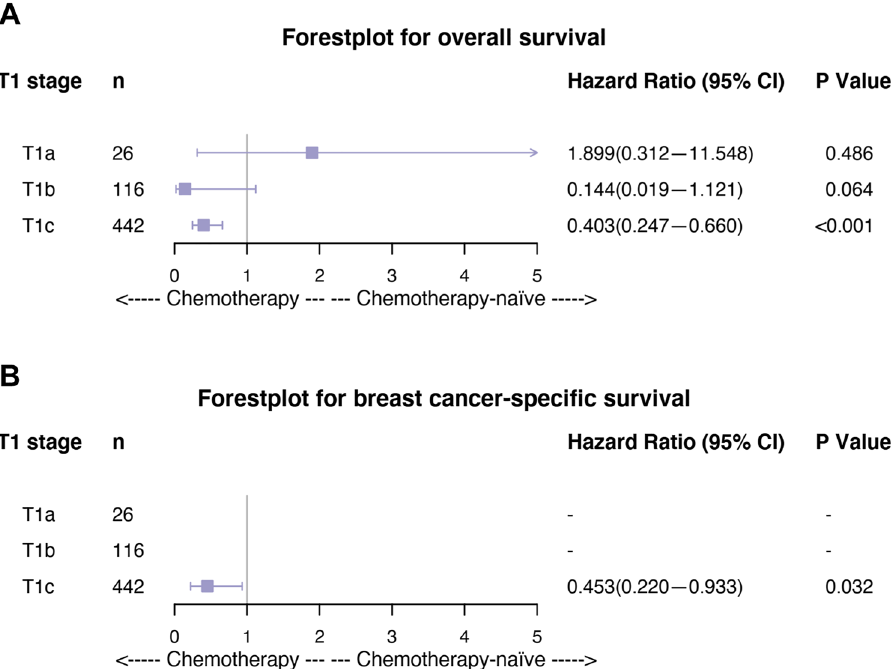
Figure 4. Forest plot of different T1 stage subgroups of MpBC patients. ( A ) Overall survival; ( B ) breast cancer- specific survival. P- values are from univariate log-rank tests, and hazard ratios (HRs) and 95% confidence intervals (CIs) are shown. Statistical inference was not available in some subsets due to the small sample size and limited